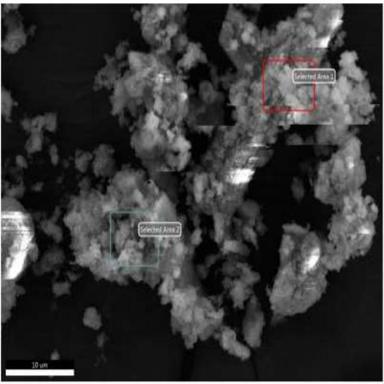
Two selected area at 2000magnification.